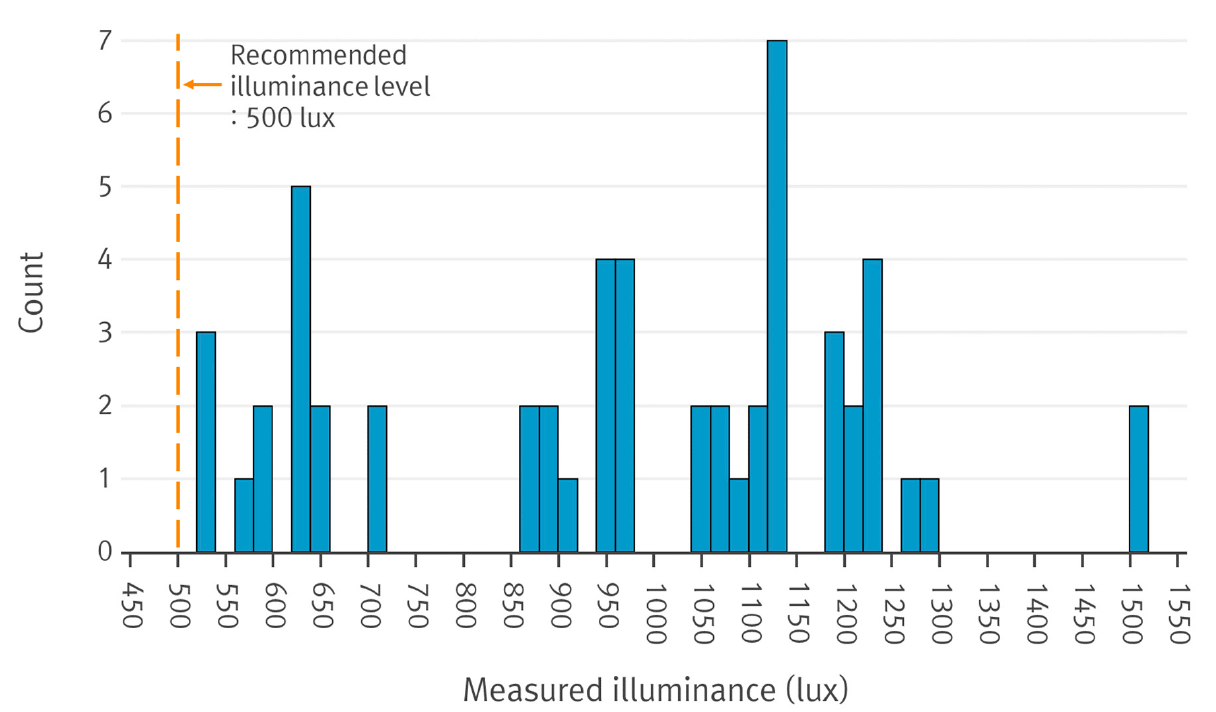
Figure 3. Histogram of the illuminance measurement values in the target classrooms.